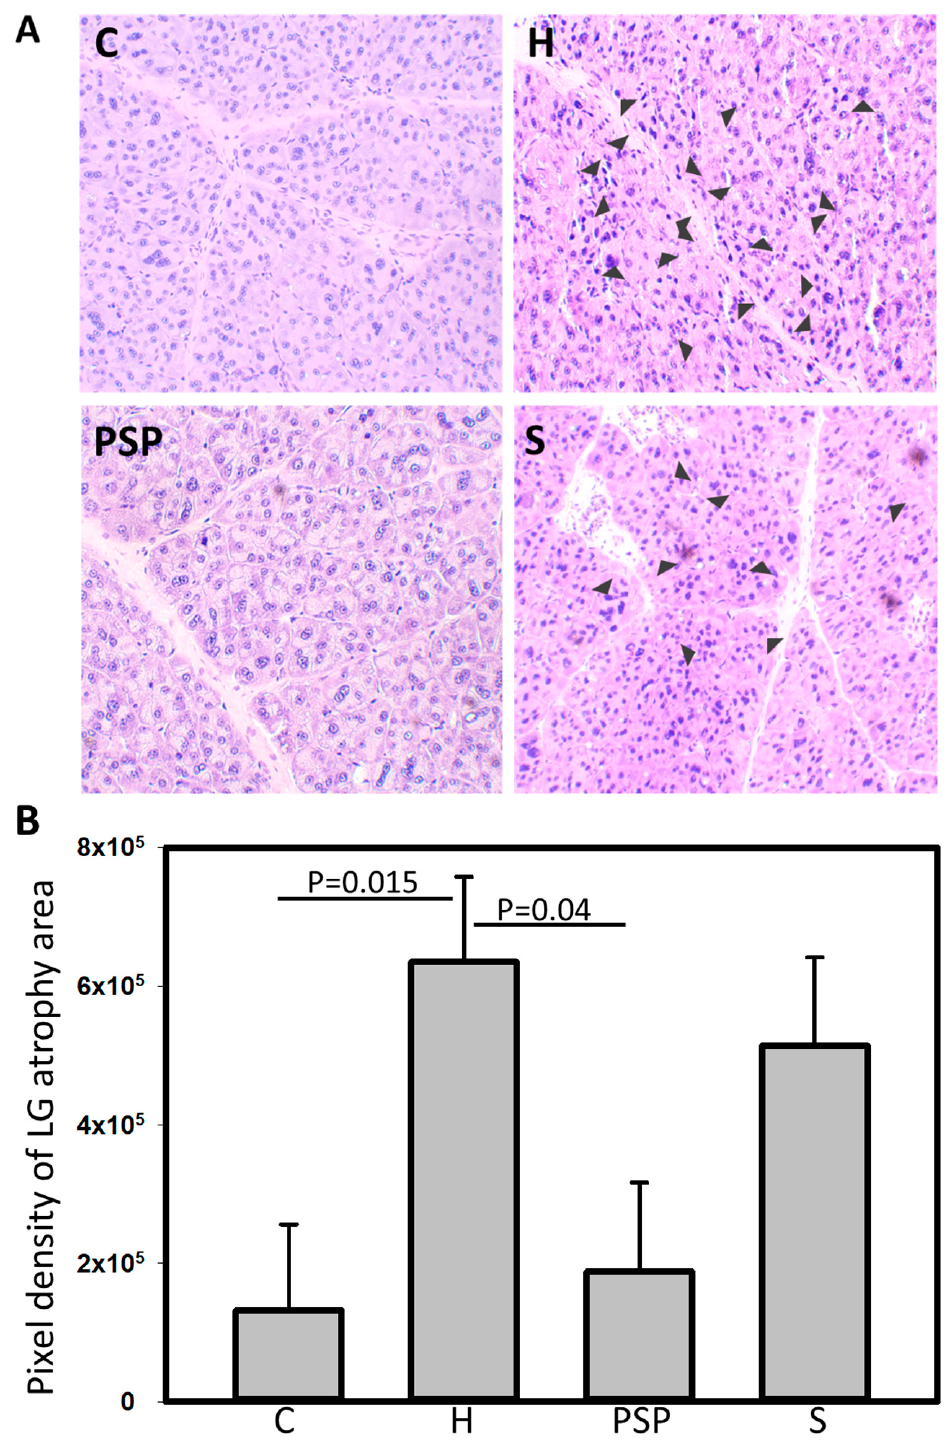
Figure 3. PSP reduced LG atrophy in HFD- treated rats. After sacrifice, one eye of each rat was obtained to perform histological examination. ( A ), the atrophy characterized by focal to confluent areas of shrunken and atrophied acini lined by small, low to flattened cuboidal cells as black arrows pointed; ( B ), the results were represented as the mean ± SD to indicate the pixel density of LG atrophy area; p values were denoted to show the significant differences.